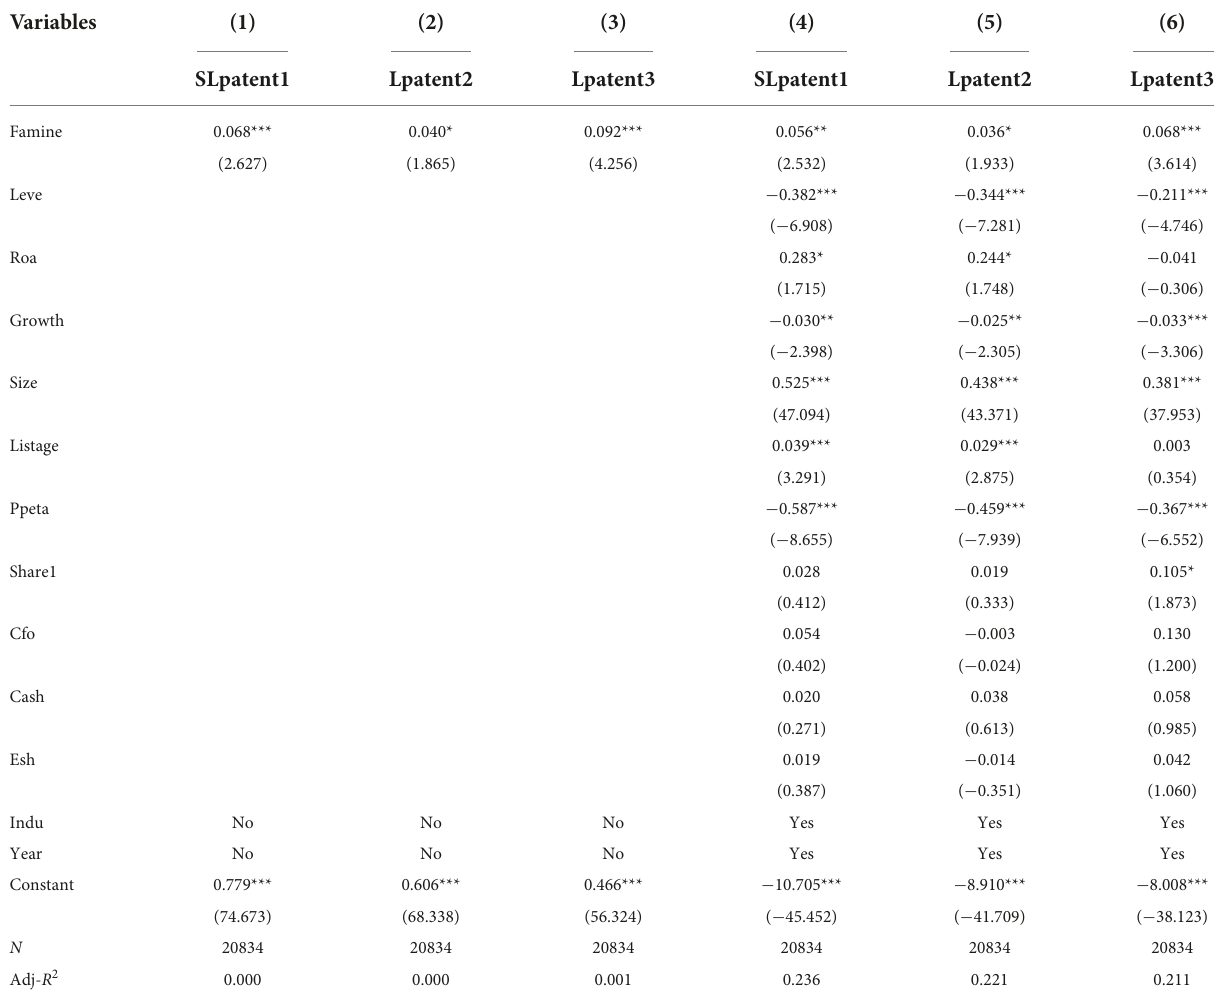
TABLE 4 Regression results of executive poverty experience and firm innovation